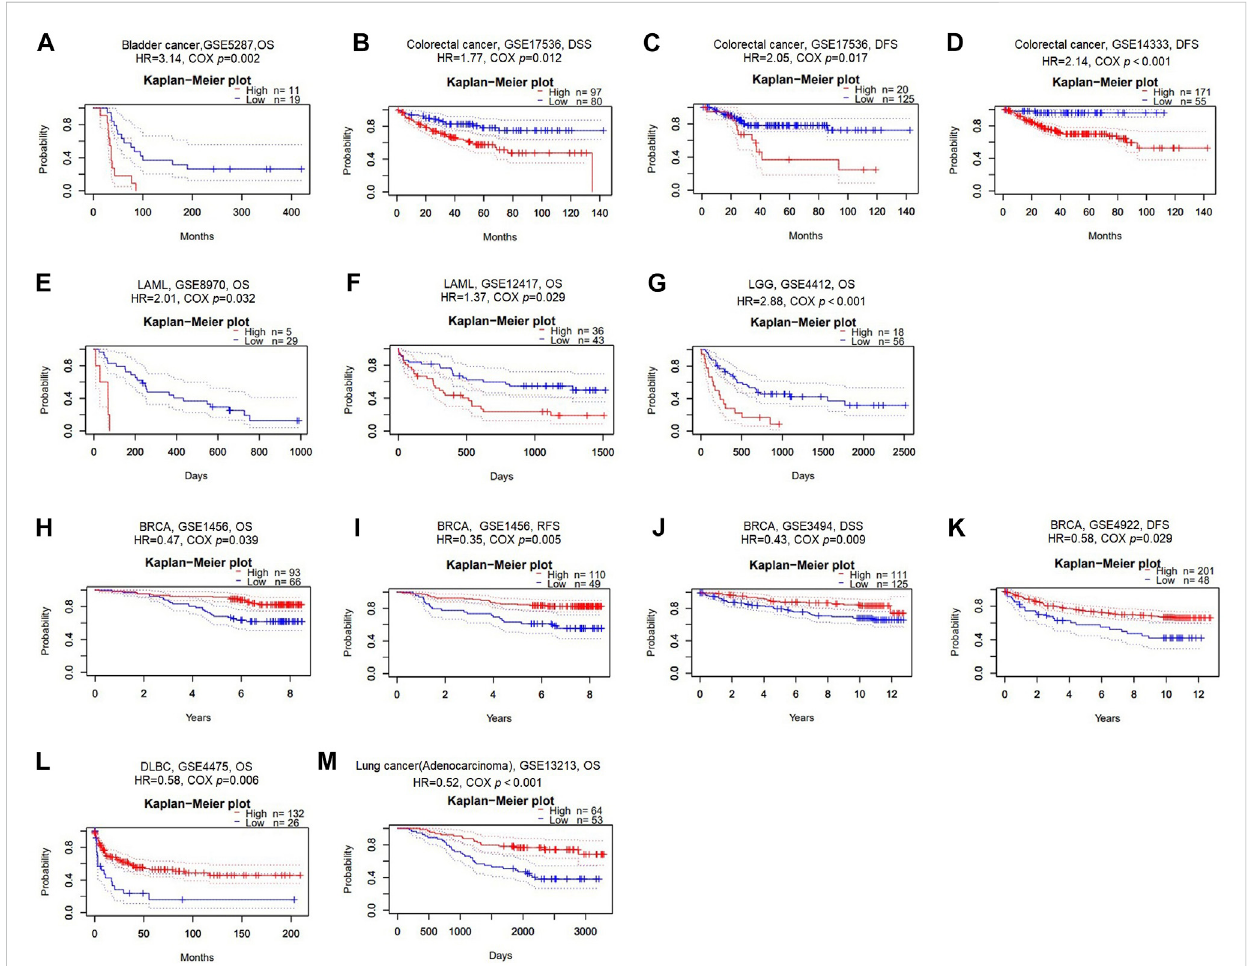
FIGURE 3 Survival analysis of GSN across different cancer types in the GEO and TCGA datasets. Kaplan-Meier plots of GSN in eleven datasets including GSE5287, bladder cancer, OS (A) ; GSE17536, colorectal cancer, DSS and DFS (B – C) ; GSE14333, colorectal cancer, DFS (D) ; GSE8970, LAML, OS (E) ; GSE12417, LAML, OS (F) ; GSE4412, LGG, OS (G) ; GSE1456, BRCA, OS and RFS (H – I) ; GSE3494, BRCA, DSS (J) ; GSE4922, BRCA, DFS (K) ; GSE4475, DLBC, OS (L) ; GSE13213, LUAD, OS (M)